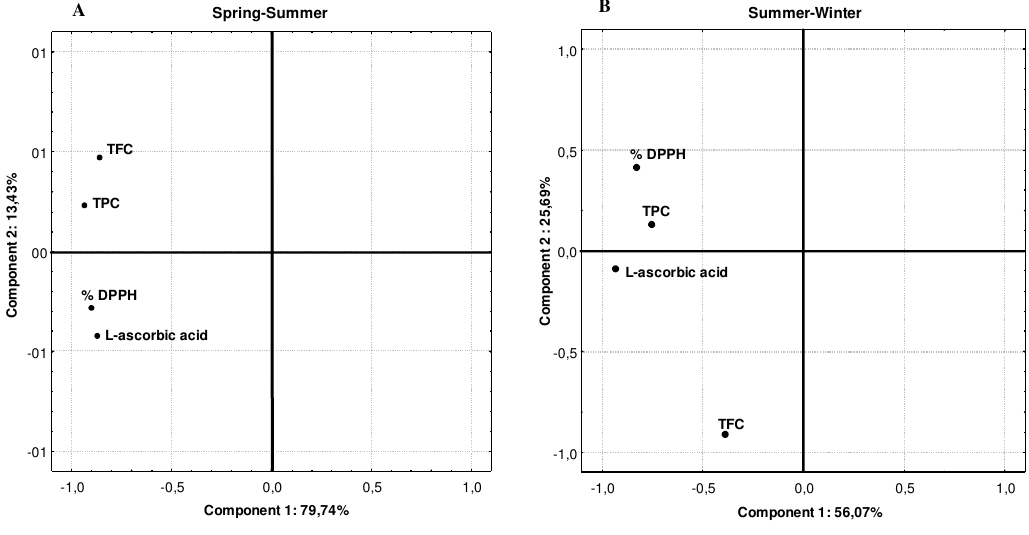
Figure 2. Principal component analysis (PCA) results, aggregating all Brassica